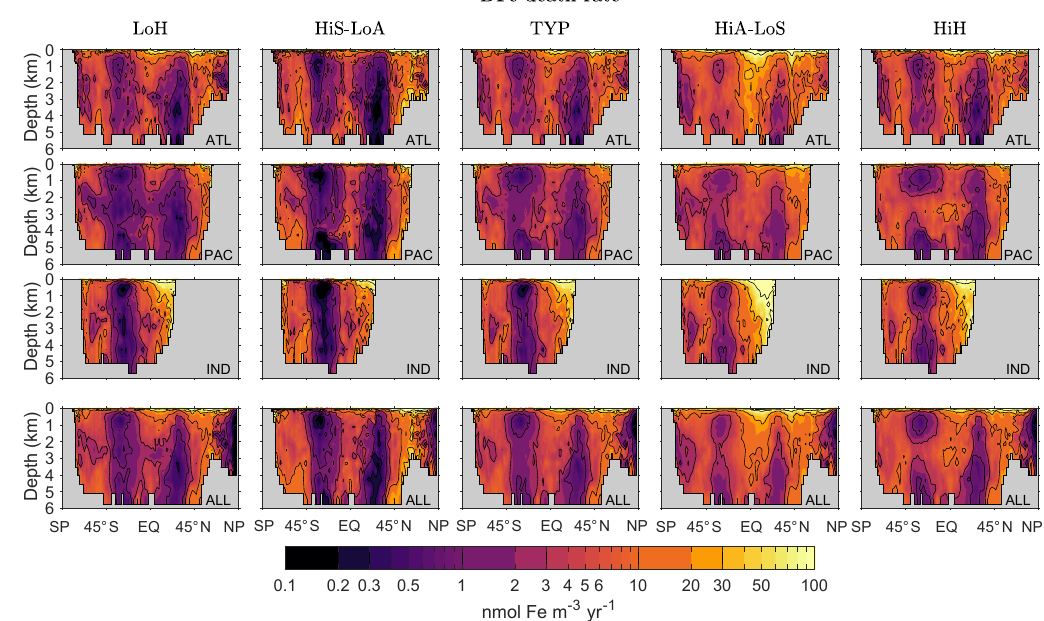
Figure C1. Basin and global zonal averages of the death rate d ( r (cid:48) ) for our five representative states. Note the logarithmic color